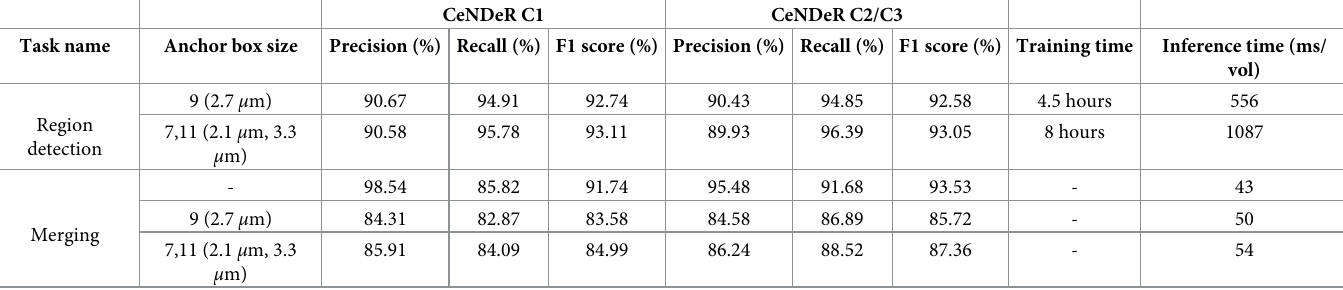
Table 2. 2D neuron detection and 3D merging results. During detection, two different sets of predefined anchor box sizes—“9 × 9” or {“7 × 7”, “11 × 11”}—are used. Three experimental 3D merging results are presented: merging of human annotated neuronal regions, where 2D detection performance is irrelevant and thereby repre- sented by “-”; 3D merging of neuronal regions detected by an ANN. Box sizes of “7, 11” have slightly better 2D detection and 3D merging F1 score, but this combination exhibits lower inference speed and requires significantly longer training time than box size “9” does. “ms/vol” refers to milliseconds per